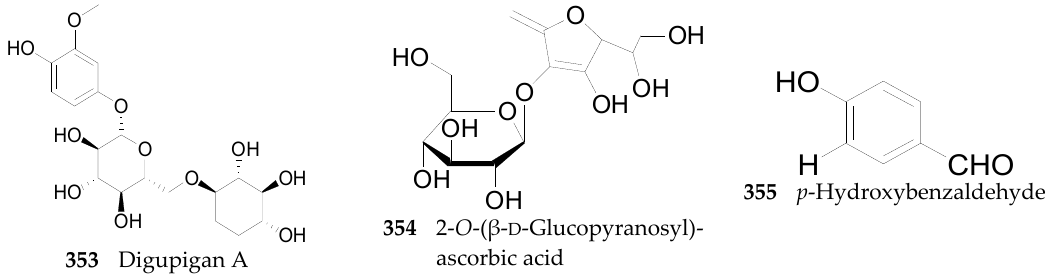
Figure 24. Chemical structures of compounds 353 – 355 .